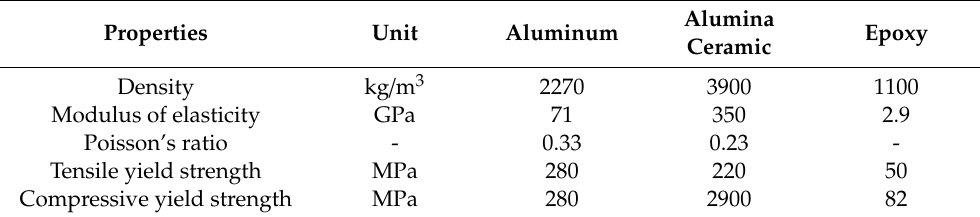
Table 5. Material properties of the aluminum and alumina